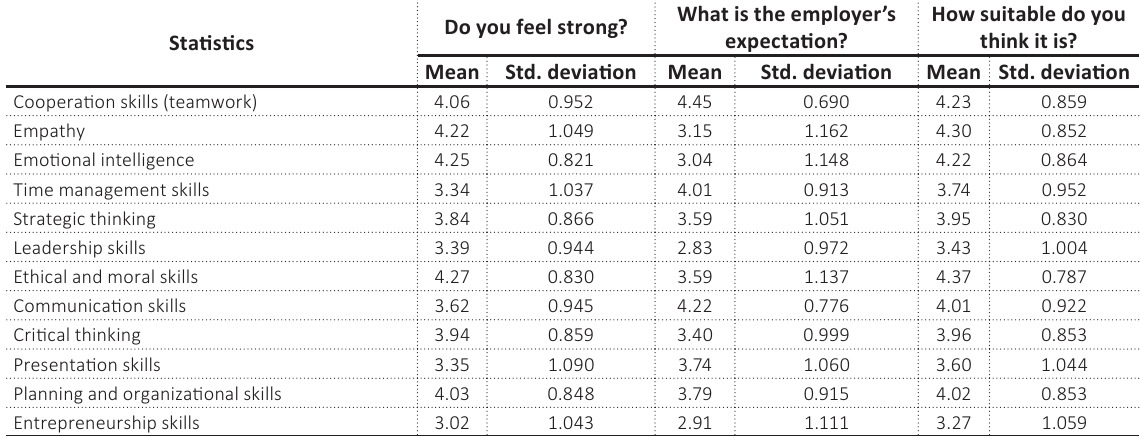
Table 3. Employers’ expectations of skills (mean, standard deviation)